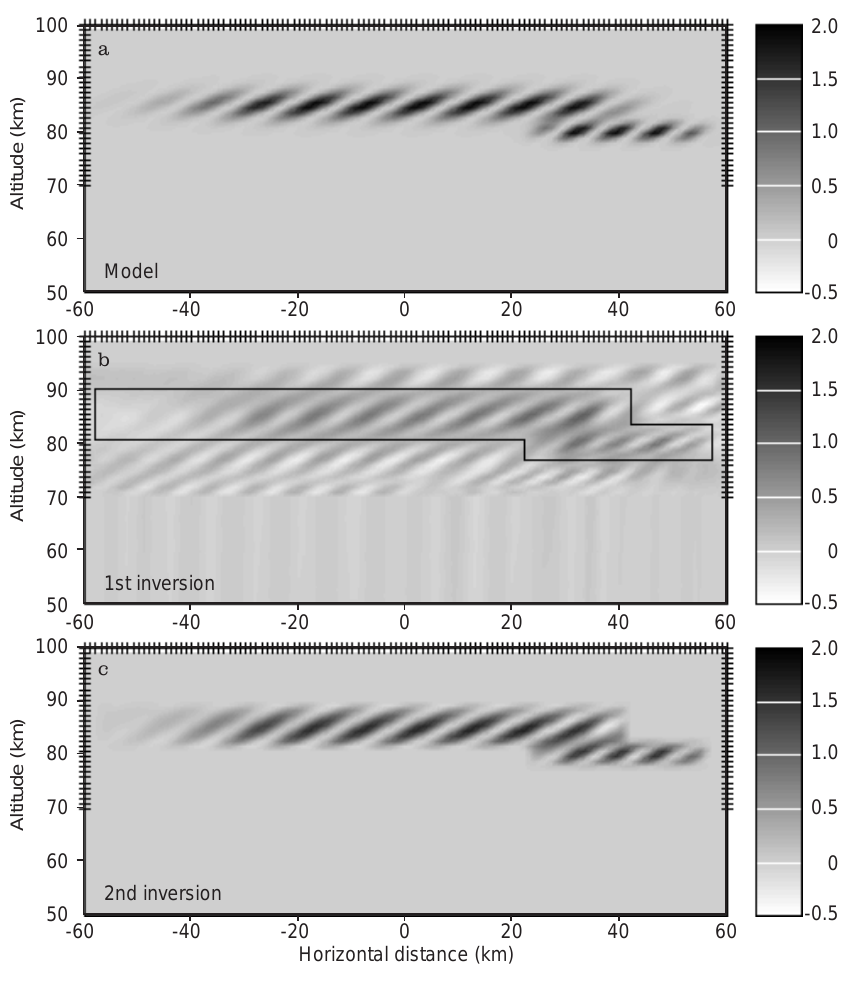
Fig. 6. Same as Fig. 3, with a second wave packet on the right-hand side of the model. The peak altitude of the second wave is 80 km, the vertical scale height of the amplitude is 1.5 km, and the horizontal and vertical wave- lengths are 7.5 and 5